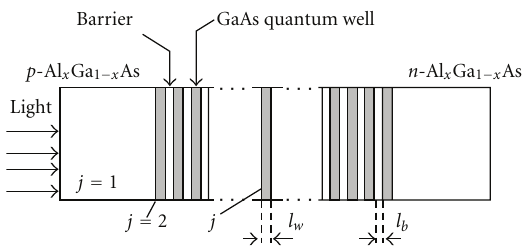
Figure 2: Geometry of a solar cell in the HM hybrid model.